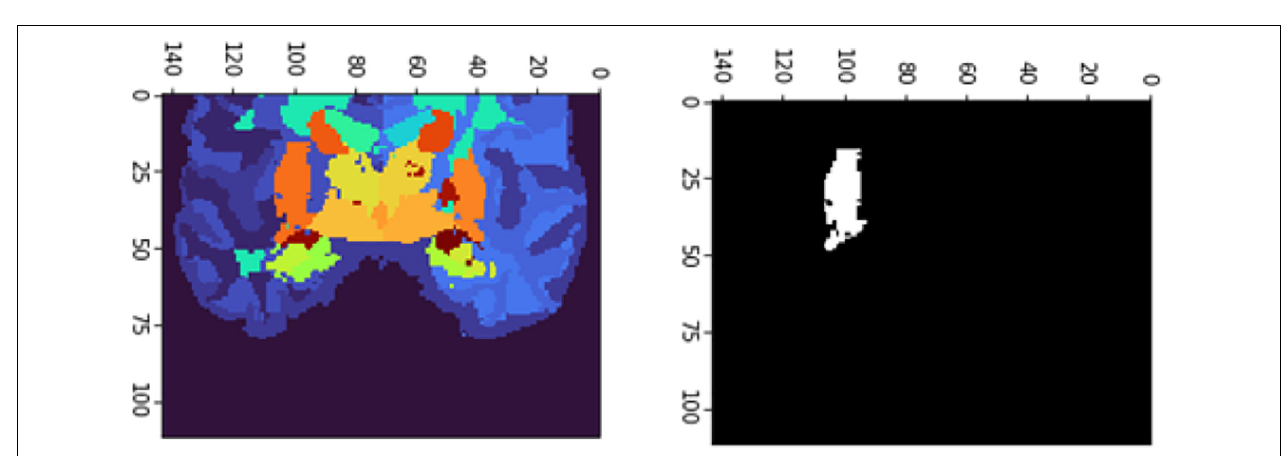
FIGURE 10 | 2D scan from the output volume of subject OAS30319_MR_d0043. We have chosen the right putamen of the brain structure whose intensity value equals 27.